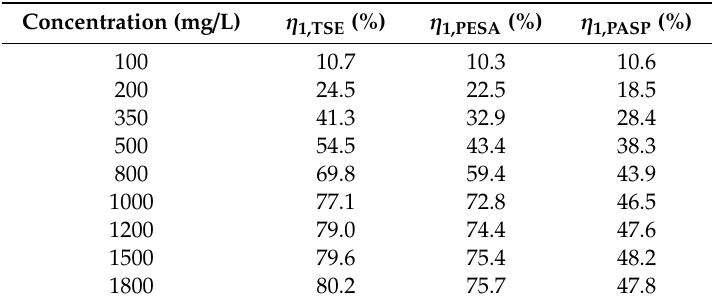
Figure 2. Changes of the corrosion inhibition rates of tobacco stem extract (TSE), polyepoxysuccinic acid (PESA), and polyaspartic acid (PASP) with increasing concentration from 0 to 1800 mg / L at 60 ◦ C. Table 1. The corrosion inhibition rates ( η 1 ) of TSE, PESA, and PASP for A3 carbon steel upon increasing the concentration from 0 to1800 mg / L (60 ◦